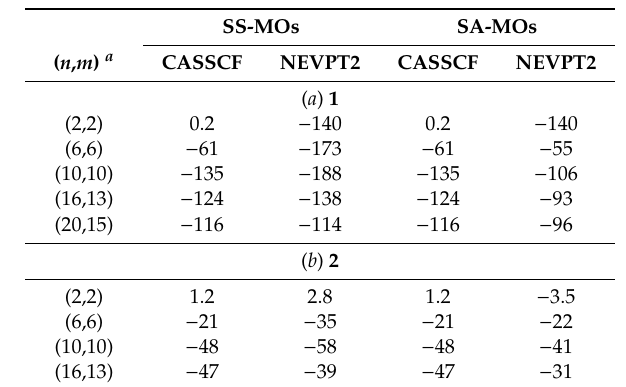
Table 1. J values (in cm − 1 ) computed for 1 and 2 at the complete active-space multiconfigurational self-consistent field CASSCF( n , m ) / n -electron valence state second-order perturbation theory (NEVPT2) level.